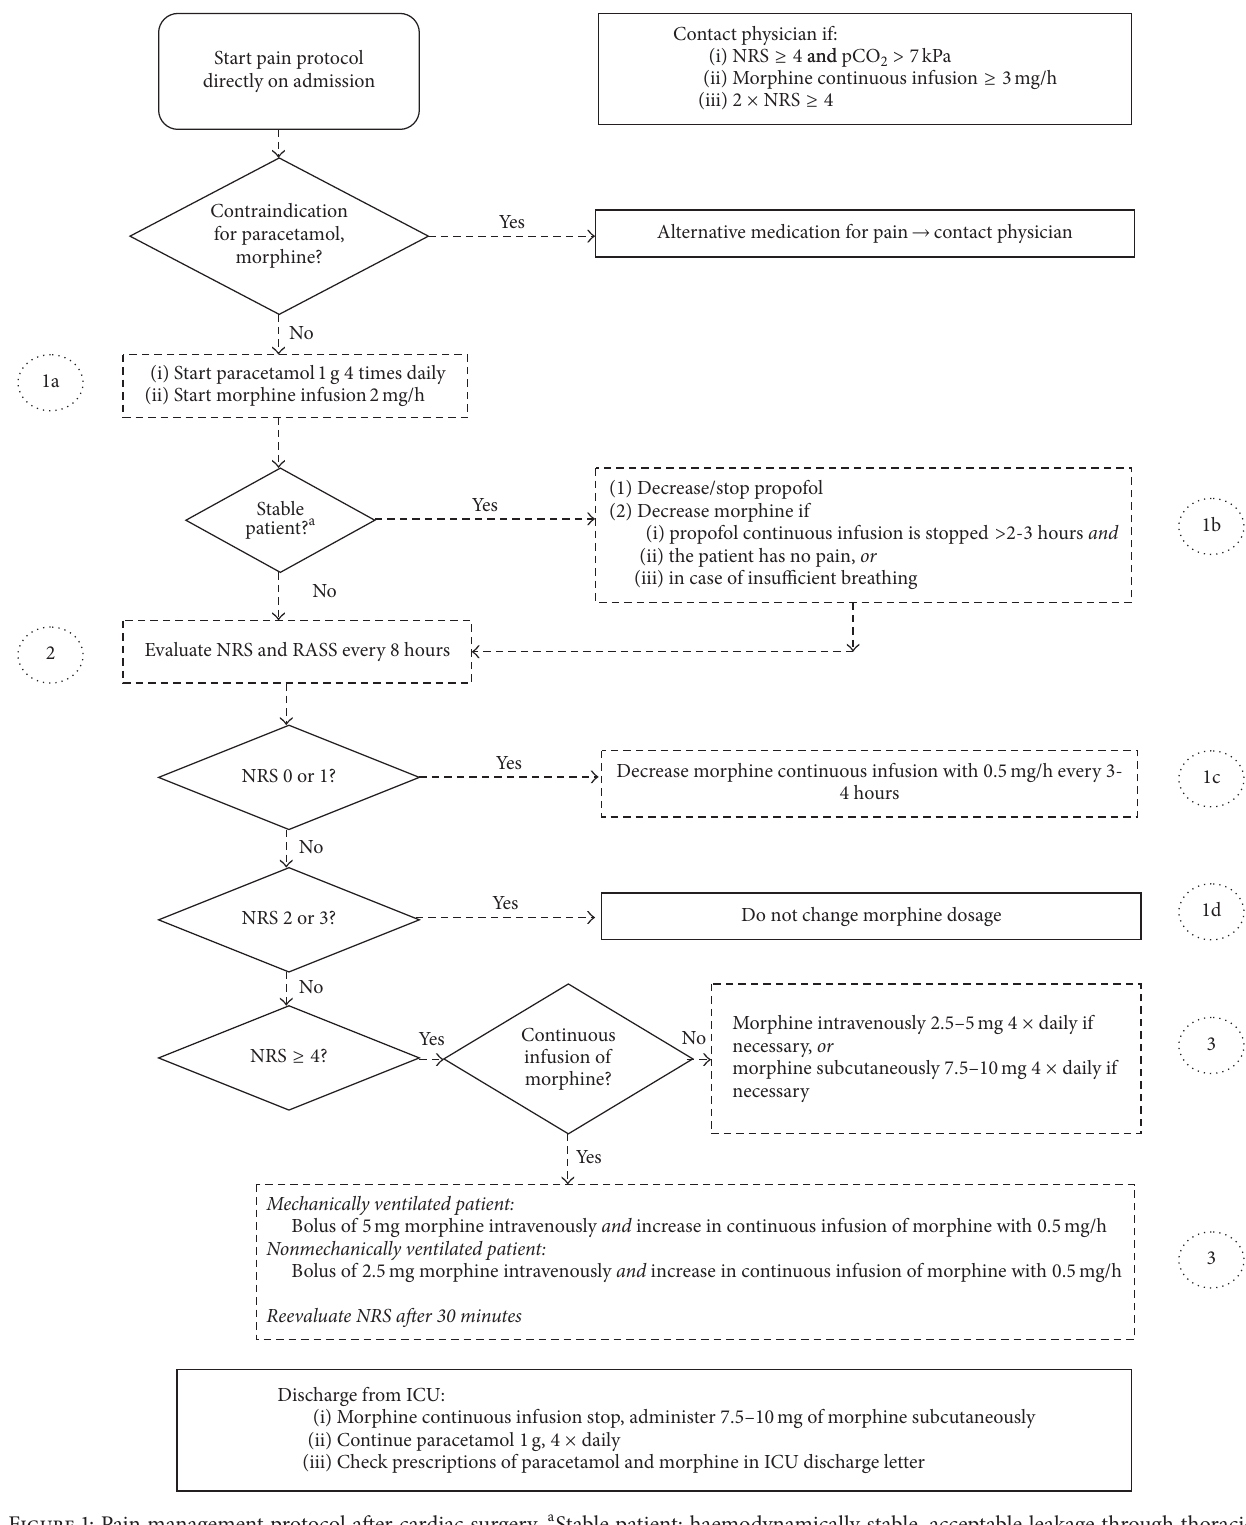
Figure 1: Pain management protocol after cardiac surgery. a Stable patient: haemodynamically stable, acceptable leakage through thoracic drains, adequate time after muscle relaxation, and adequate core temperature; NRS: numeric rating scale, RASS: Richmond Agitation and Sedation Scale, ICU: intensive care unit, and 1(a, b, c, d), 2, and 3: items concerning adherence to the pain protocol referred to in the